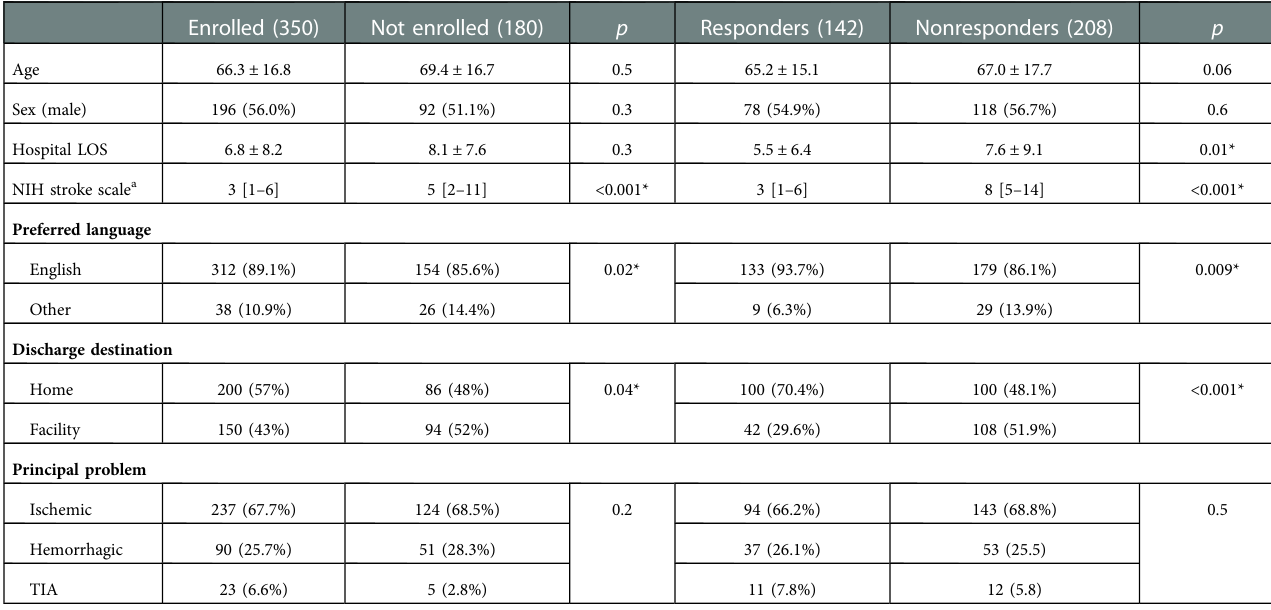
TABLE 1 Cohort demographic and clinical